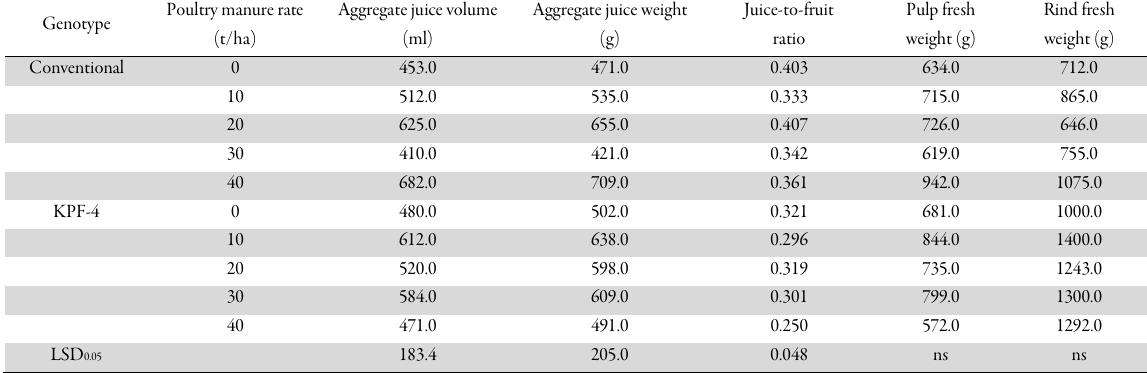
Table 8. Interaction effect of genotype and poultry manure rates on juice metric traits of yellow passion fruit grown in the field in 2015 Genotype